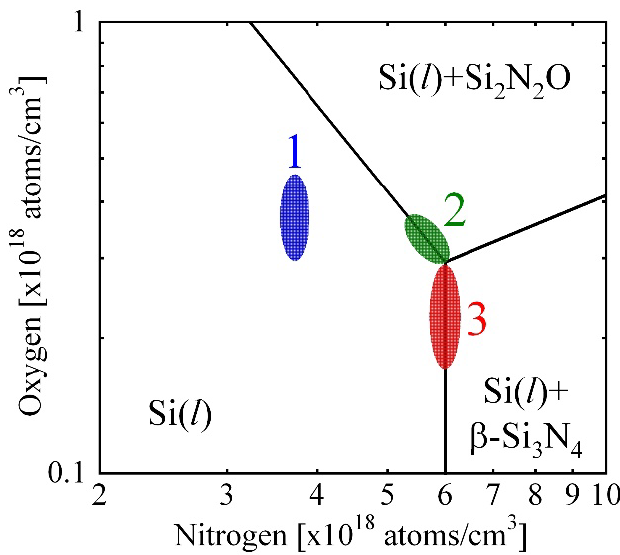
Figure 11. Schematic diagram of the reaction of Si 3 N 4 and Si 2 N 2 O as a function of O and N concentrations in the Si melt in the Si(l)–N–O phase diagram. Numbers 1,2 and 3 denotes in the area Si(l), the boundary between Si(l) and Si(l) + Si 2 N 2 O and the boundary between Si(l) + Si 2 N 2 O and Si(l) + Si 3 N 4 . Reproduced using data from reference [17].